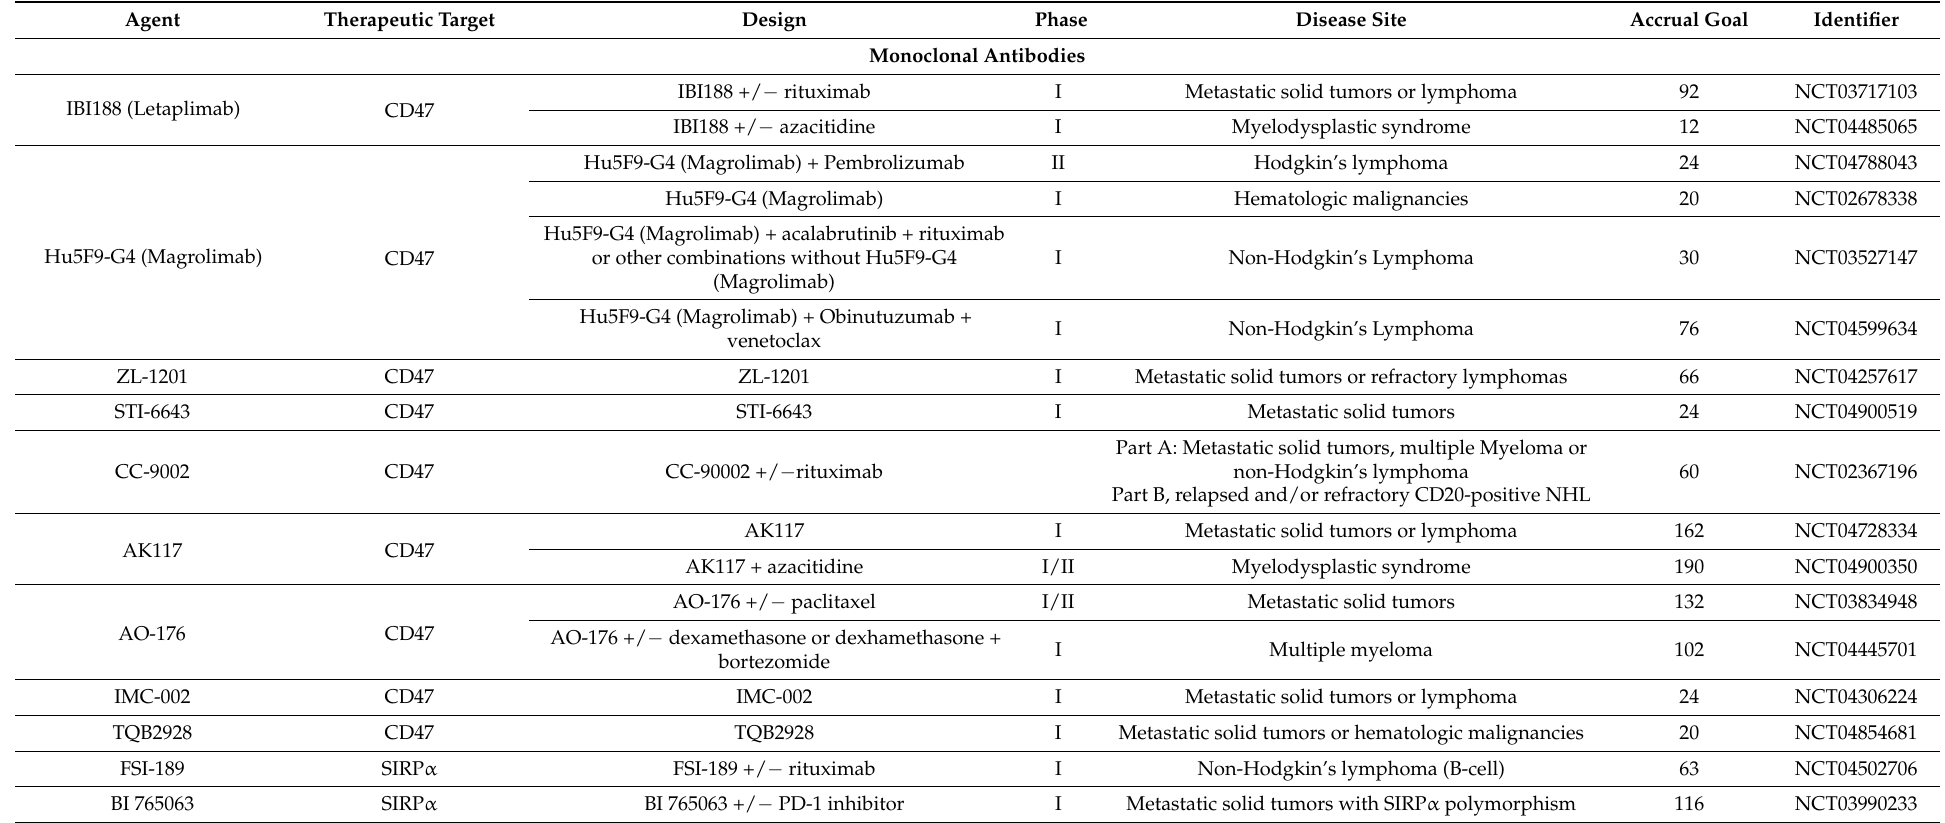
Table 1. Clinical trials testing agents targeting CD47/SIRP α